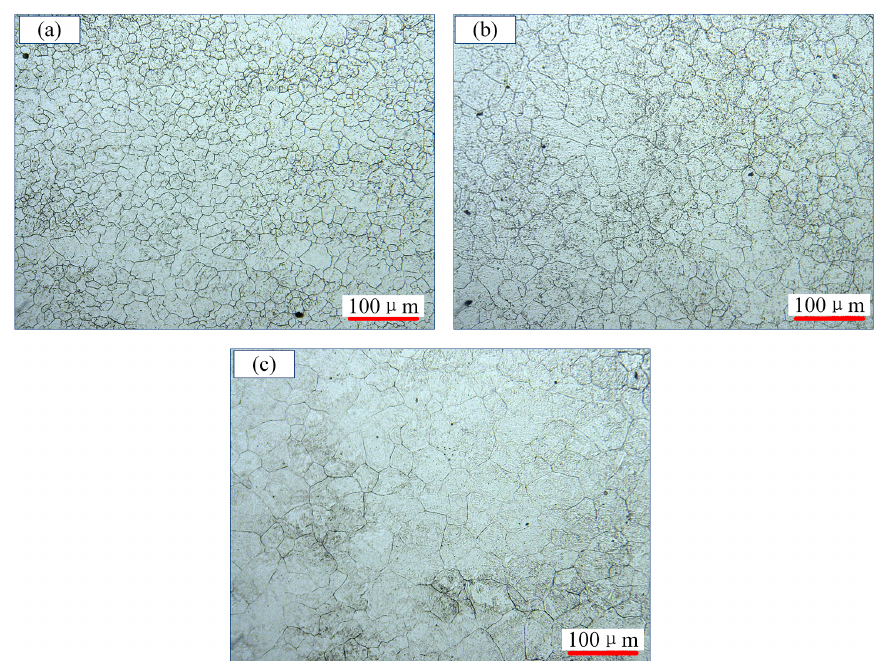
Figure 3. Microstructures of 300M steel deformed at 10 s − 1 at: ( a ) 1050 °C; ( b ) 1150 °C; and ( c ) 1200 °C.